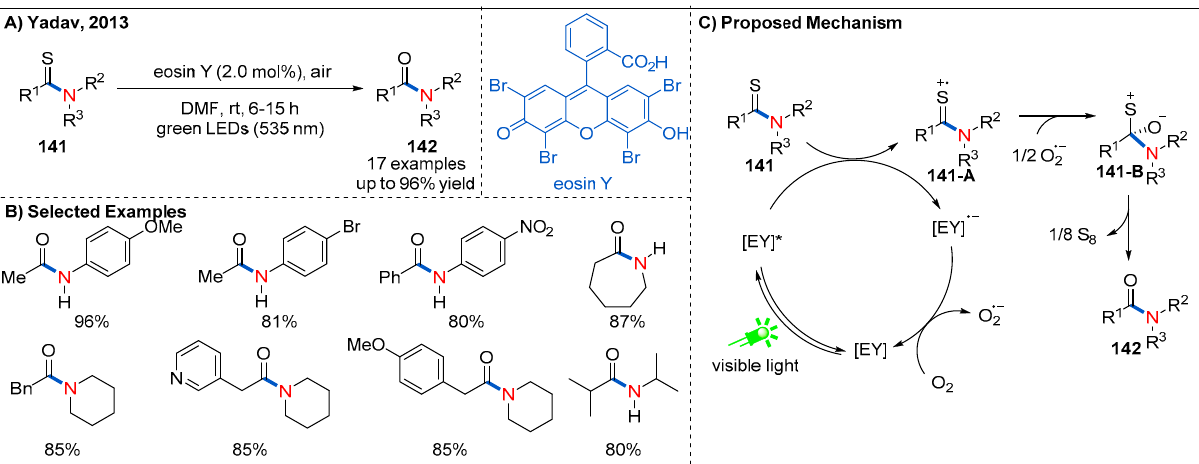
Figure 42. Visible-light-driven aerobic desulfurization–oxygenation of thioamides.